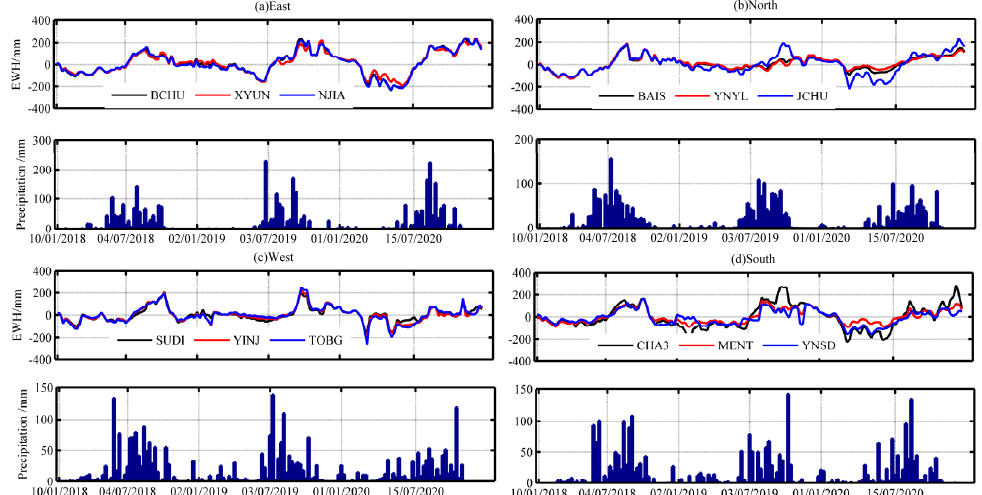
Figure 8. GWSA at Different CORS stations and precipitation amounts in different sub-study areas.